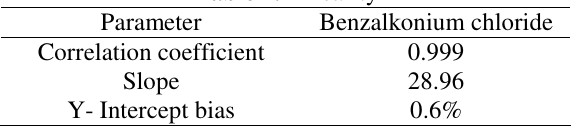
Figure 6. Linearity curve of preservative analogue benzalkonium chloride